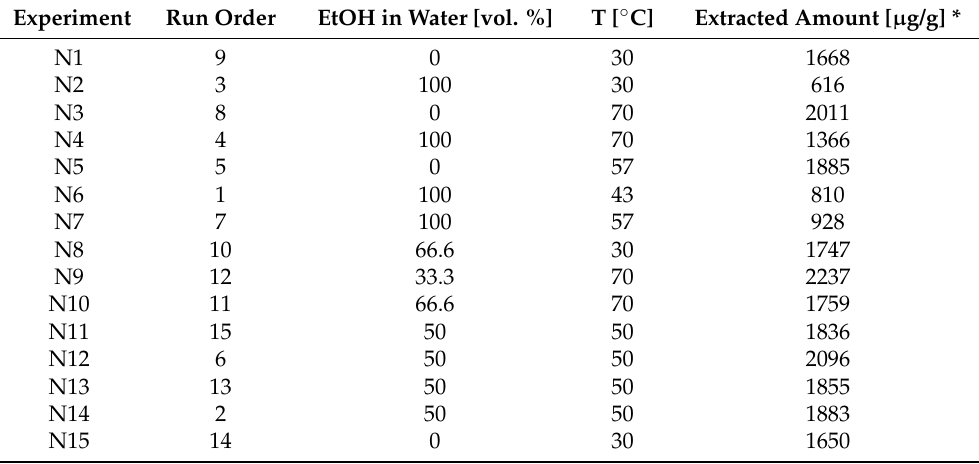
Table 2. Set of experiments for UE optimization using D-optimal